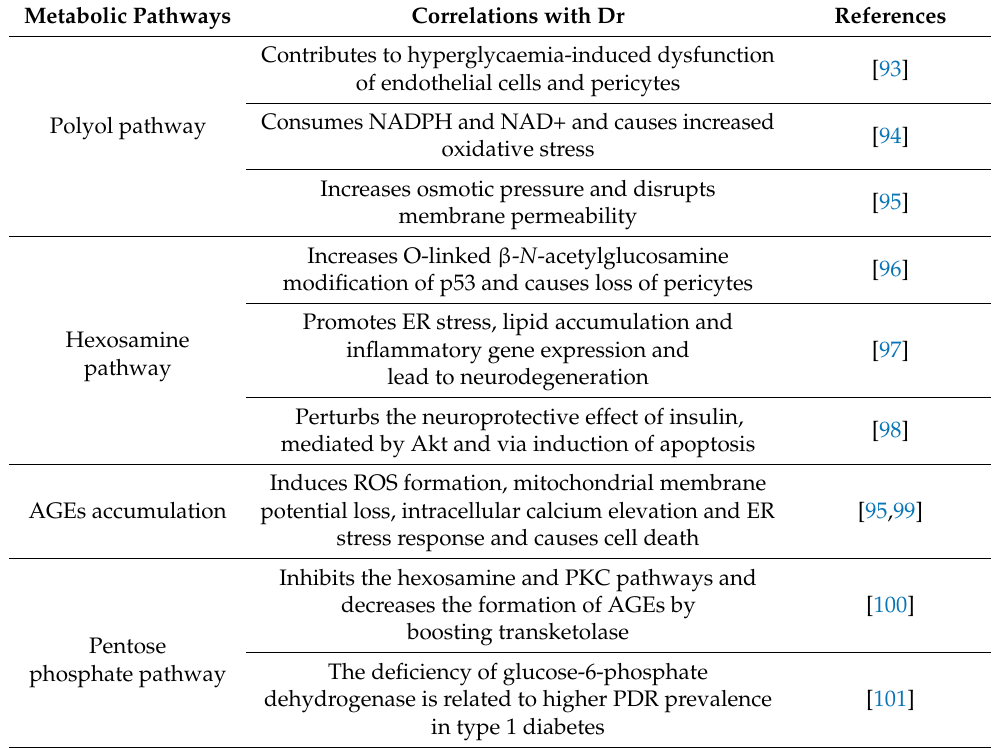
Table 2. Main metabolic pathways and their correlations with